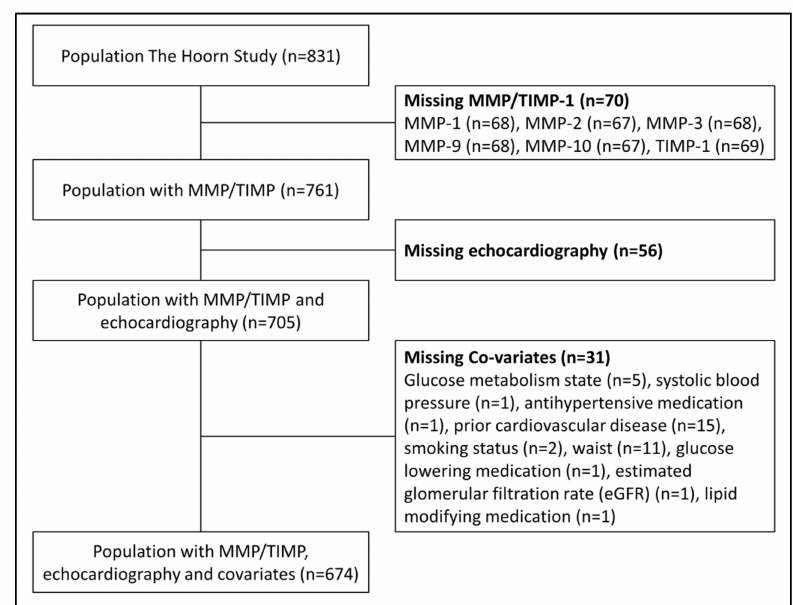
Figure 1. Selection of study population. Abbreviations: MMP; matrix metalloproteinase, TIMP; tissue inhibitor